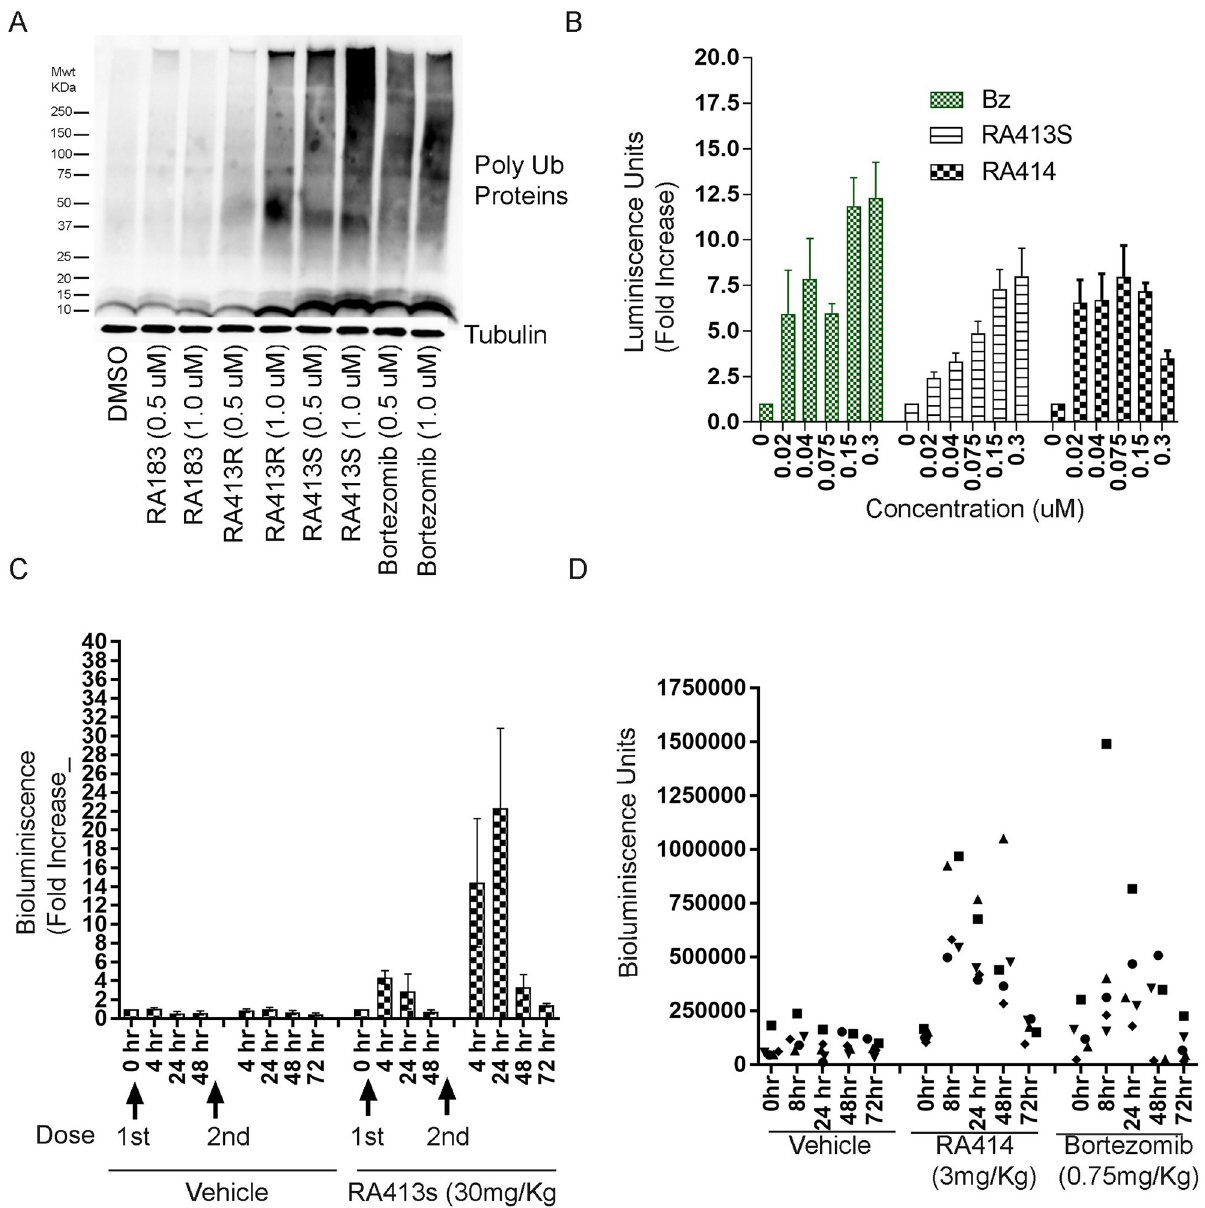
Fig 4. Compounds inhibit proteasome function in vitro and vivo. (A) SKOV3 cells were treated with compounds for 4 h and analyzed by Western blot with antibody to ubiquitin to assess the accumulation of high molecular polyubiquitinated proteins associated with proteasomal inhibition. (B) Fold increase in bioluminiscence of ES2 cells stably expressing 4UbFL at 4 h post-treatment of compounds, as measured by luminometer. (C & D) Leg muscle was electroporated after i.m. injection with 4UbFL plasmid. 3 days later IVIS200 imaging was performed upon injection of D-luciferin to assess the bioluminescence of female CD1 mice leg muscle before (0 h) and 4, 24, 48, and 72h after drug treatment. Increased bioluminescence was observed after treatment with RA413S; the first dose utilized PEG formulation, and the second dose 72 h later used a b-HPCD formulation. (C, figure showing fold increase) or RA414 or bortezomib (D, figure showing bioluminescence units for individual